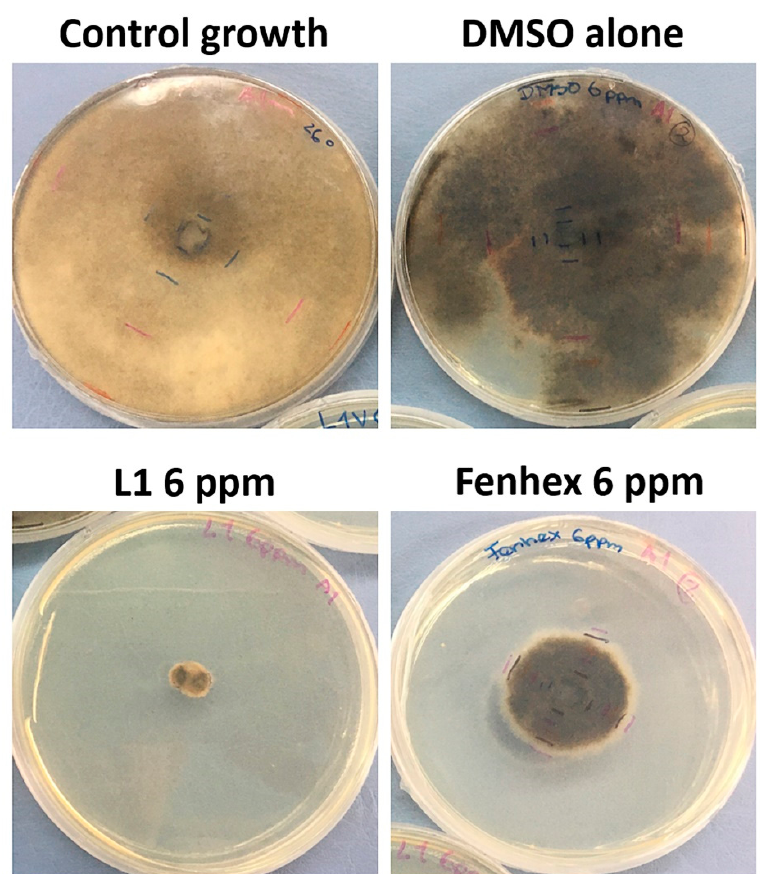
Figure 5. Antifungal effect against Botrytis cinerea A1 (at 26 °C) exerted by L1 in a dose-dependent manner (12 days of incubation). Inhibition of mycelial growth (by measuring the colony diameter) was observed in the presence of L1 (6 ppm) and compared with the commercial fungicide fenhexamid (6 ppm). Since both L1 and fenhexamid stock were dissolved in DMSO (vehicle), DMSO alone was also tested, adding the same concentration used with either L1 or fenhexamid in each case (0.045% v / v ). The figure shows a representative experiment, showing the fungal colony growth.